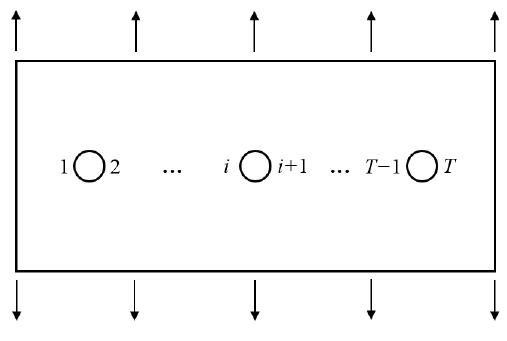
Figure 3. MSD structure